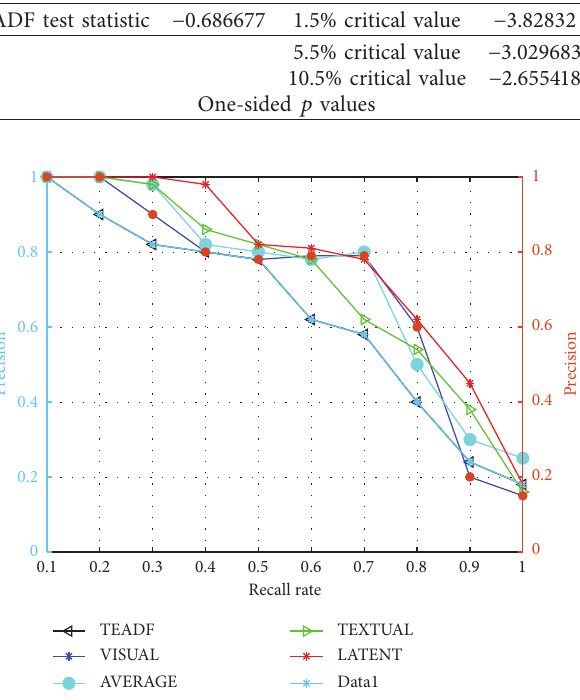
Table 3: Unit root test